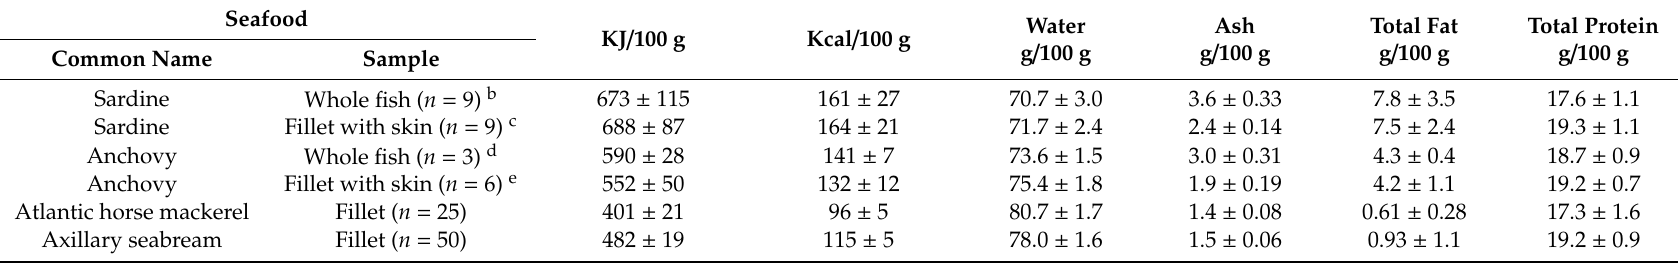
Table 3. Analytical values for energy, total fat, and total protein in di ff erent species of fish sampled on the EAF Dr. Fridtjof Nansen cruise from Tangier to Cap Bojador in May 2017 (mean ± SD) a .